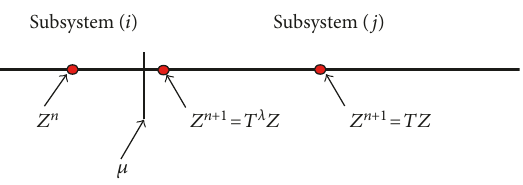
Figure 3: Sketch of the predictor-corrector algorithm.